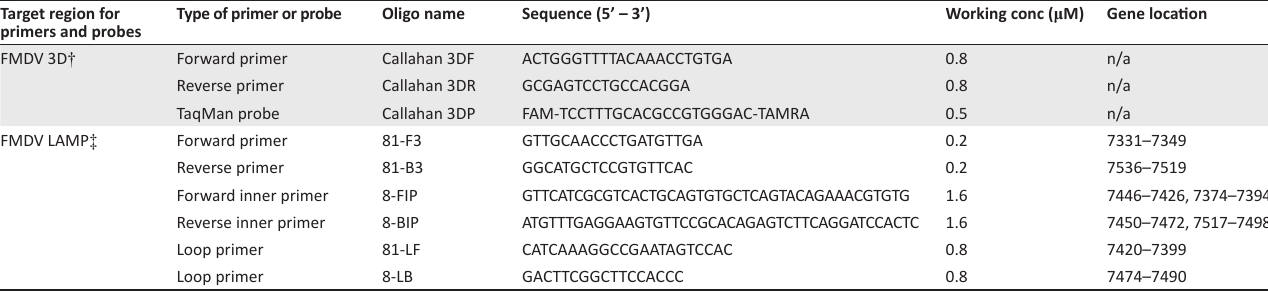
TABLE 1: Primers and probes used for one-step RT-qPCR and RT-LAMP for the detection of FMDV. Target region for primers and